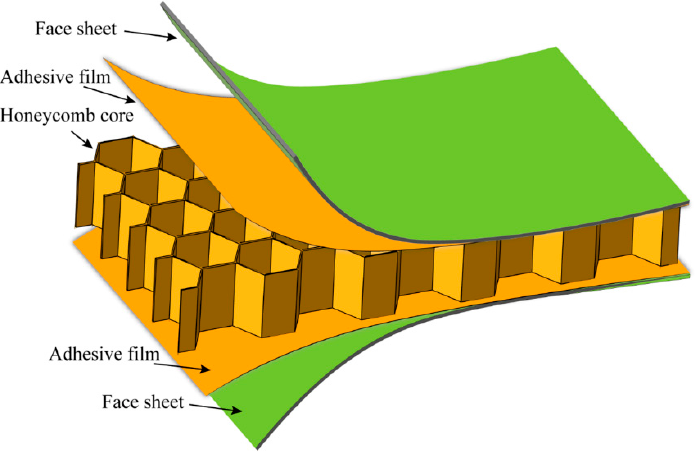
Figure 1. Typical honeycomb sandwich structure.